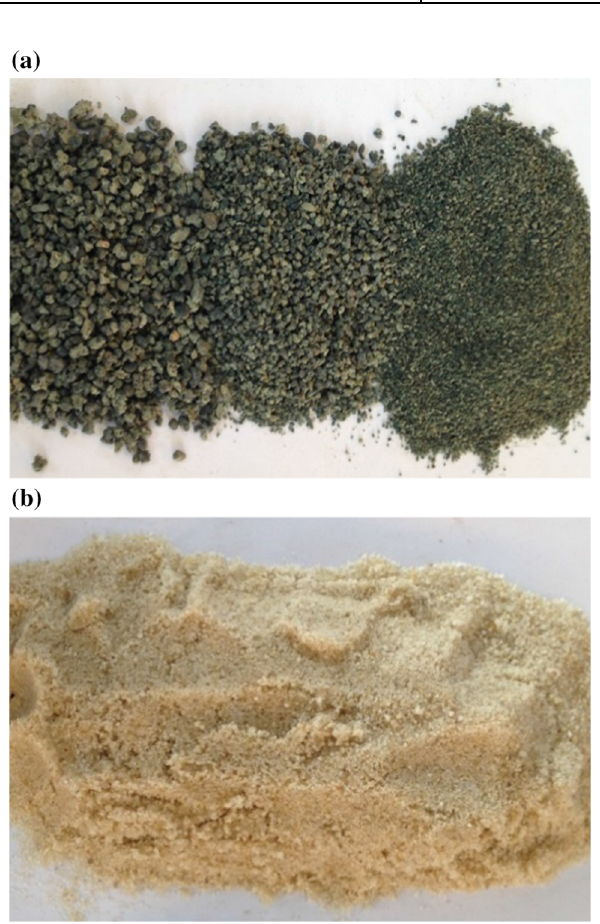
Fig. 2 a Ferronickel slag aggregate and b natural sand.